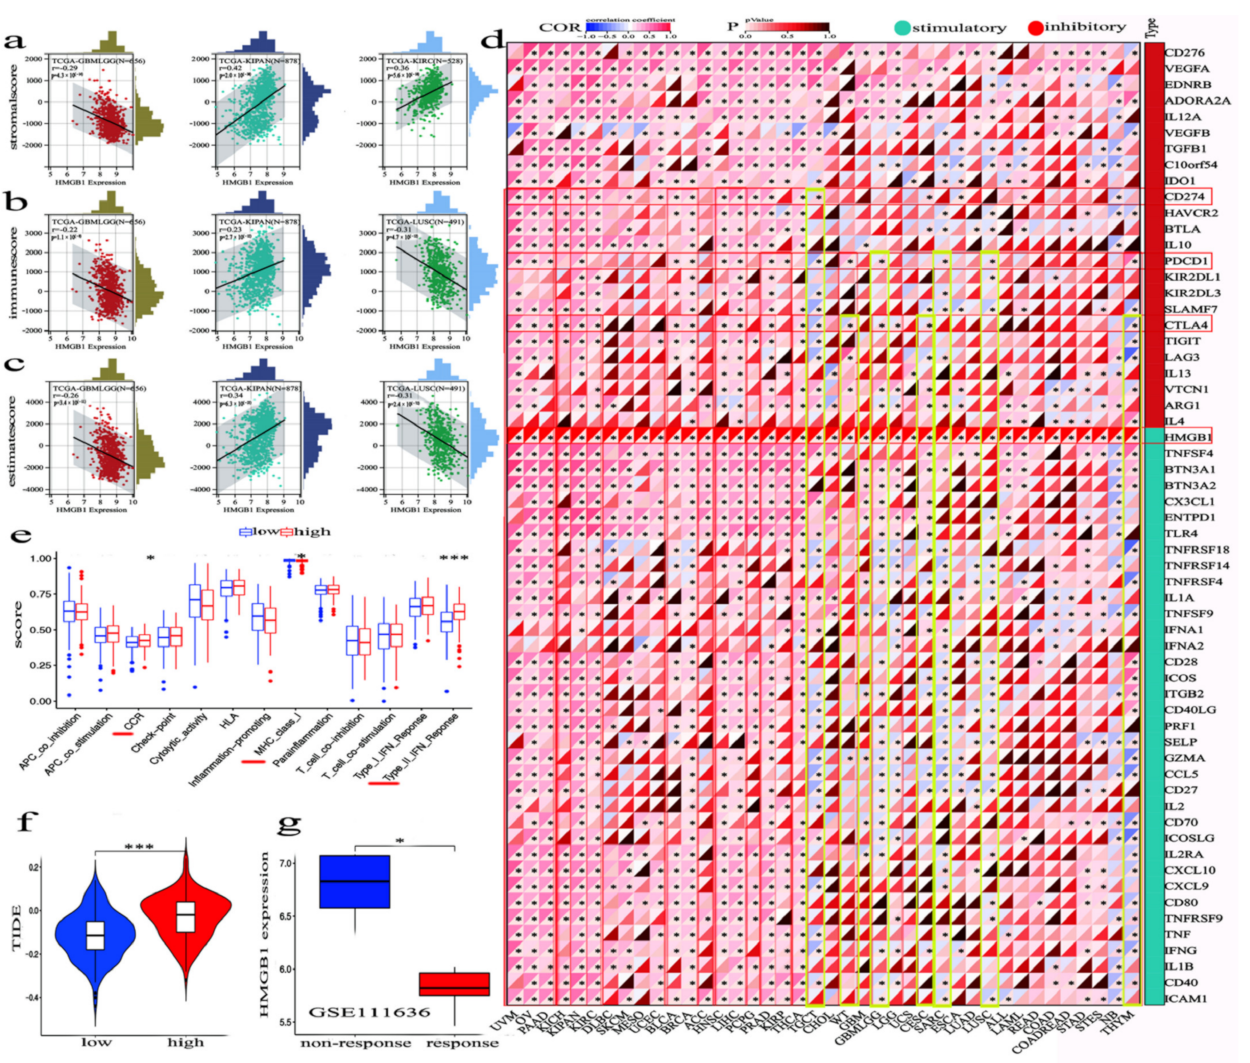
Figure 6. The correlation between HMGB1 expression and ICPs in multicancer types. ( a ) Stromal scores of TME ( b ) Immune scores of TME for tumor samples. ( c ) Estimate scores of tumor purity in multicancer cases. ( d ) All immune checkpoint-related genes were closely correlated with HMGB1 expression as evaluated by ssGSEA algorithm. The color indicates the cor value. * Statistically significant p -value calculated (Pearson correlation analysis) p < 0.05. ( e ) Analysis of immune function difference of HMGB1. ( f ) The correlation between expression of HMGB1 and tumor immune escape. ( g ) The correlation between the expression of HMGB1 and patients with therapeutic response to PD1 blockade immunotherapy. * Statistically significant p -value calculated (Pearson correlation analysis) p < 0.05, *** p <